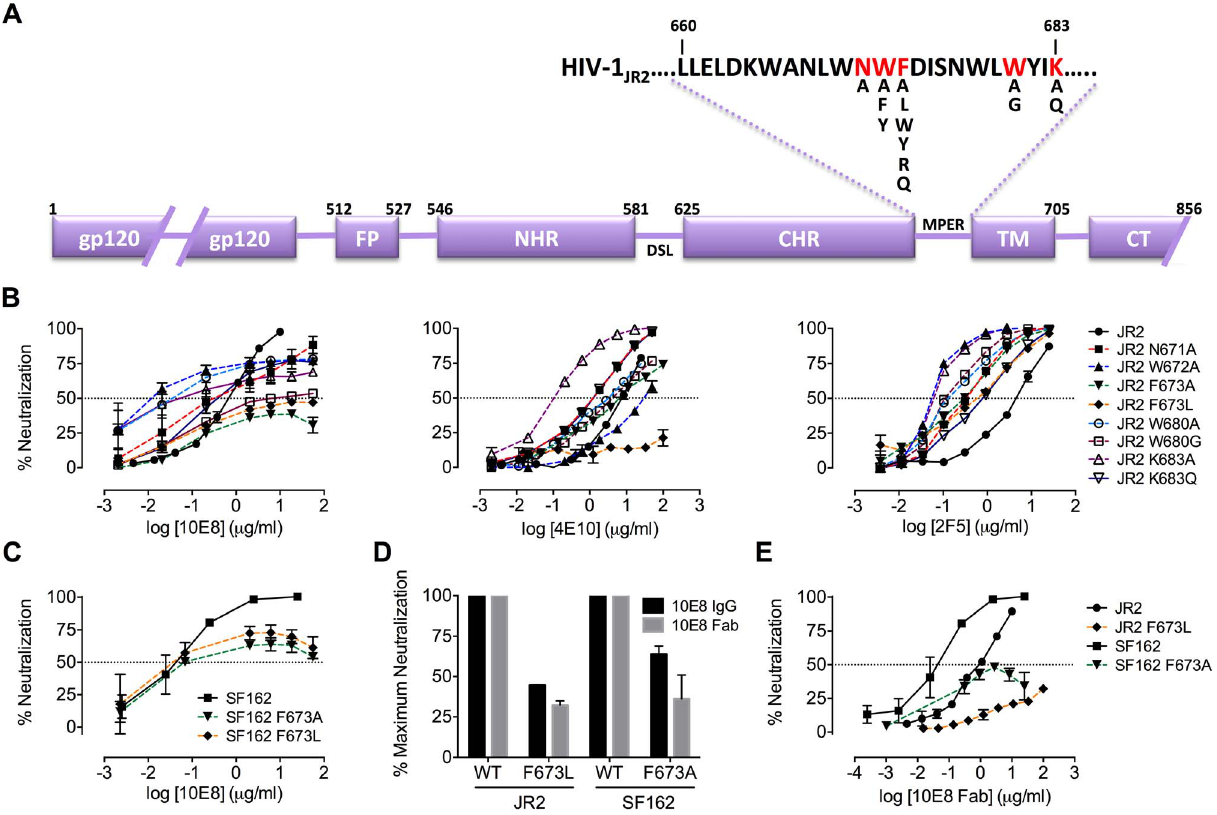
Figure 1. Partial neutralization of HIV-1 JR2, SF162 and corresponding MPER mutants by 10E8. ( A ) Diagram of the MPER and surrounding domains of HIV-1 gp41 with residues found to be important for neutralization by 10E8 highlighted in red. ( B ) Neutralization of JR2 and cognate MPER mutants against broadly neutralizing antibody 10E8 (left) performed side-by-side with 4E10 (middle) and 2F5 (right). ( C ) Neutralization of SF162 wild type and F673 mutants by 10E8. ( D ) Maximum neutralization (plateau) percentages and ( E ) dose response neutralization curves of 10E8 (IgG and Fab) against JR2 and SF162 wild type and F673 Ala mutants. Error bars are from two independent experiments [n=2] performed in duplicate using TZM-bl target